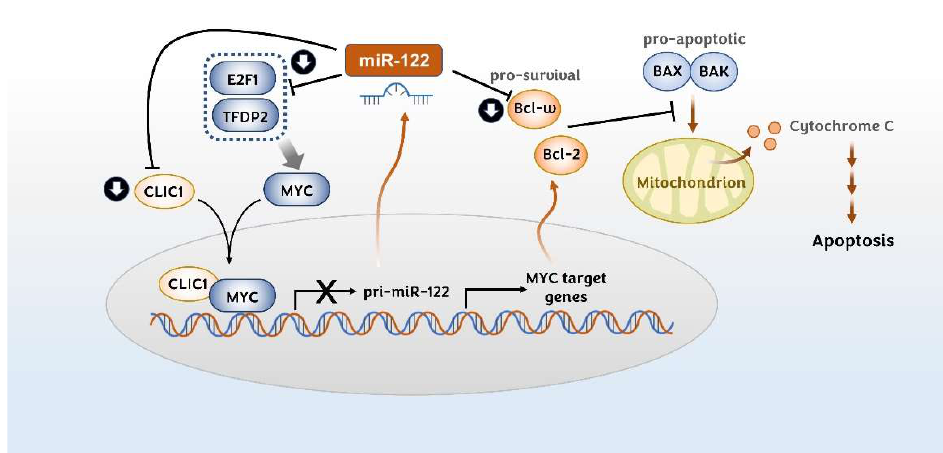
Figure 3. Regulation of MYC signaling pathway and Bcl family proteins by miR-122. miR-122 and MYC reciprocally regulate each other. MYC bound with CLIC1 suppresses the transcription of miR-122, whereas miR-122 downregulates CLIC1, E2F1, and TFDP2, leading to the suppression of the MYC signaling pathway. miR-122 can suppress the expression of the prosurvival Bcl family protein, Bcl-ω, and MYC-induced Bcl-2 expression, which could enhance the action of proapoptotic Bcl family members.